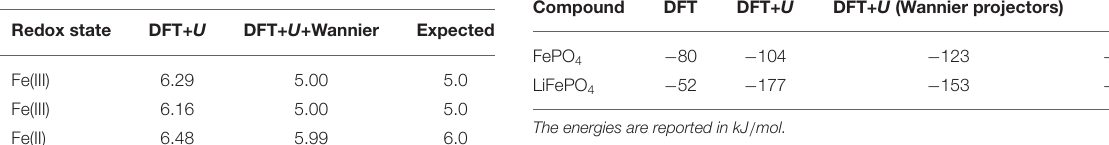
TABLE 3 | The computed projected total number of d electrons per Fe atom in Fe 2 O 3 , FePO 4 and LiFePO 4 compounds using the DFT+ U approach with atomic orbitals and Wannier functions as projectors. Compound